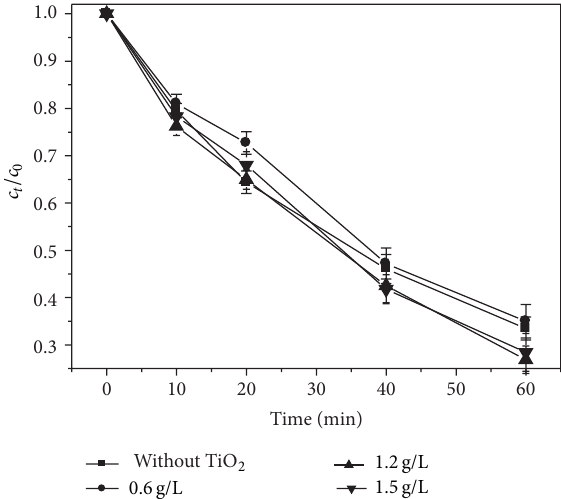
Figure 7: Effect of Fe(II) on ultrasonic degradation of fuchsin basic (initial dye concentration = 10 𝜇 molL −1 , ultrasonic power = 400 W, ultrasonic frequency = 25 kHz, tempetature = 22 ∘ C, and pH = 6.5).